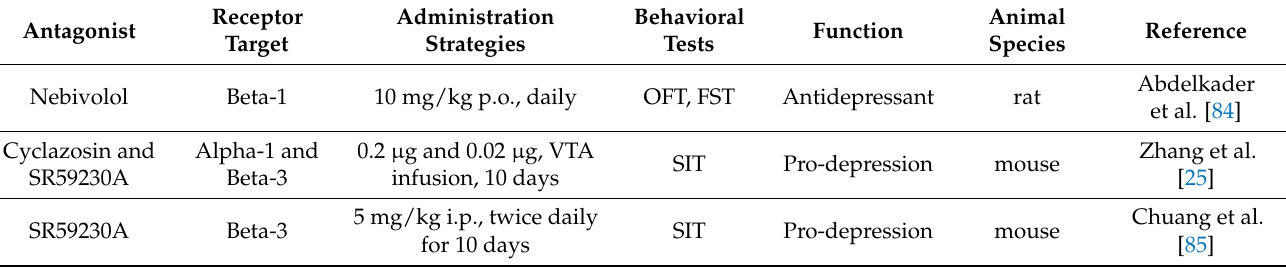
Table 3. Beta-adrenoceptor antagonists tested in animal studies.